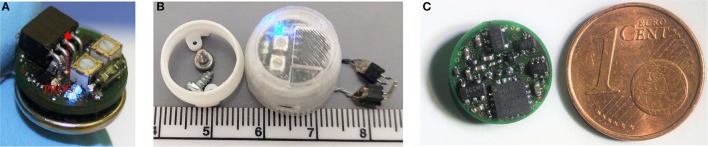
Photographs of the portable stimulator. The top side is shown, complete with a battery, its programming port (highlighted), potentiometers, reed switch and DBS LED's (A). The system was utilized with a 3D-printed waterproof cap, which mounts onto a skull-implanted electrode socket (B). The underside of the system is shown, alongside a coin for scale; highlighting the high component density (C).